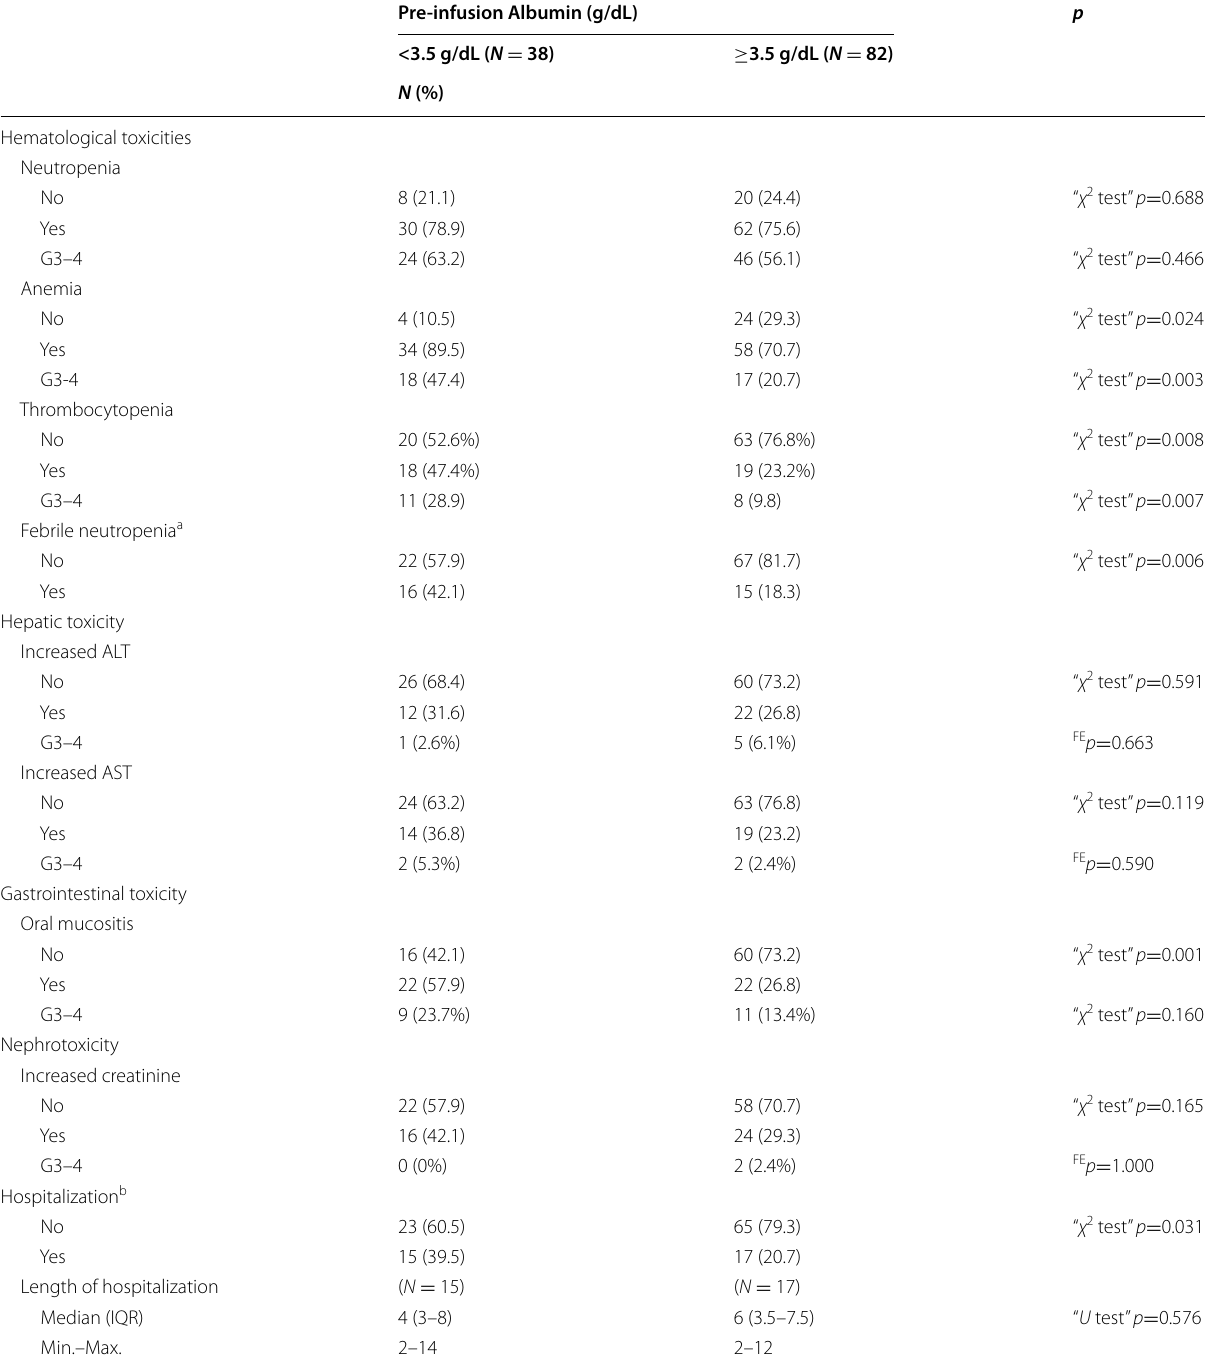
Table 2 Relation between pre-infusion albumin level and commonly observed toxicities of the HDMTX cycles ( N